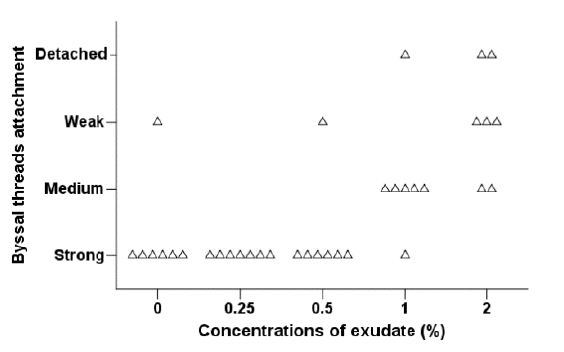
Figure 8. Byssal attachment strength on threads produced by M. galloprovincialis during 96 h to different concentrations of A. armata exudate. Δ represents each mussel.